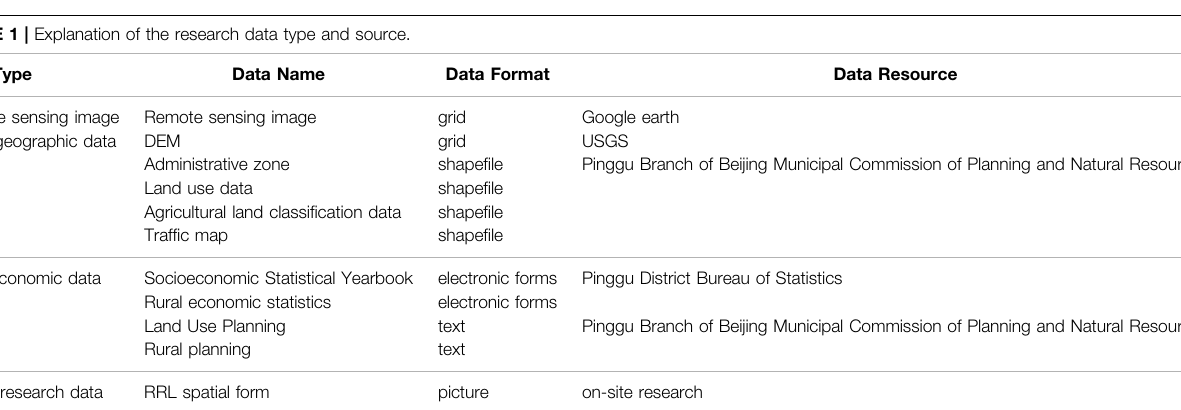
TABLE 1 | Explanation of the research data type and